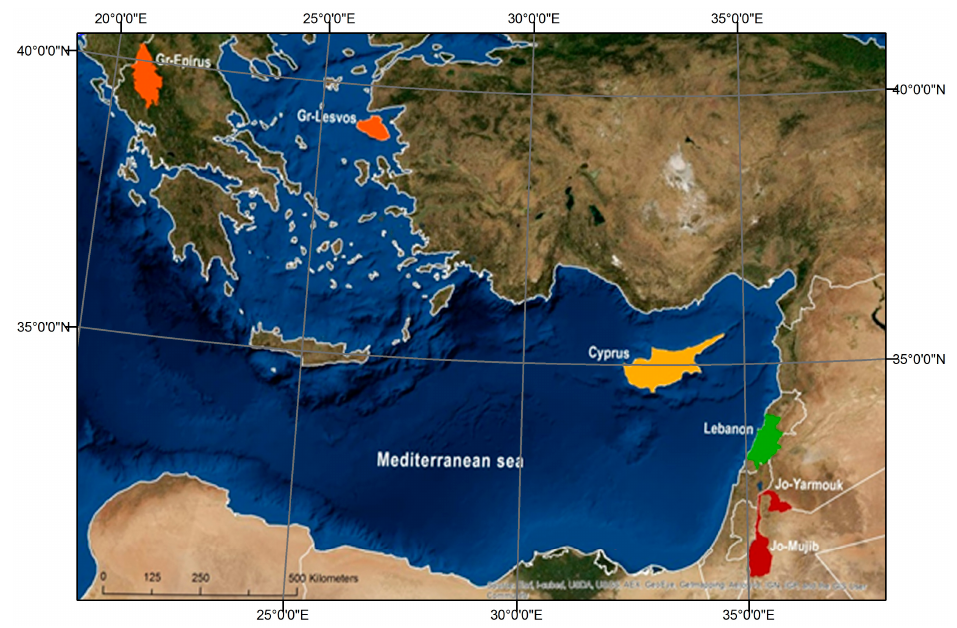
Figure 1. Location of the six study areas, different color indicates study areas located in different countries (from west: Orange = Greece; Yellow = Cyprus; Green = Lebanon and Red = Jordan).